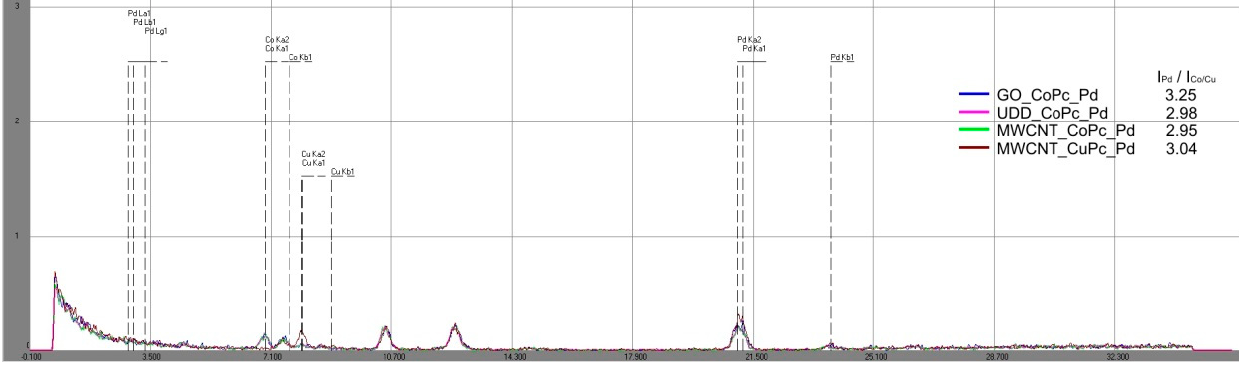
Figure 4. XRF spectrum of the studied samples.